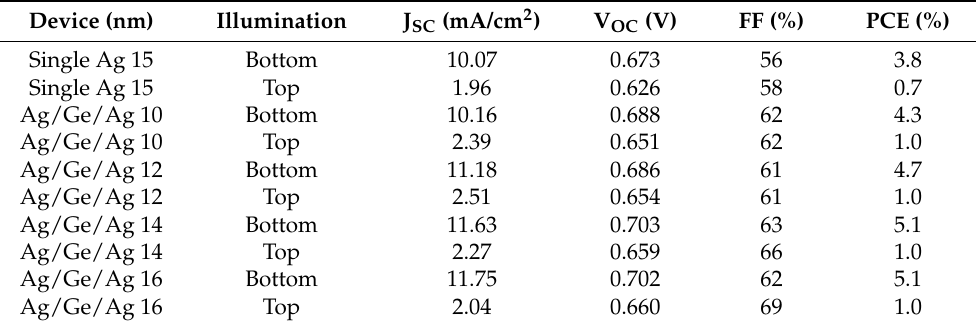
Table 1. Characteristic data of semitransparent inverted PSCs with different thicknesses of the Ag capping layer, as illuminated from the ITO (bottom) and the Ag/Ge/Ag (top) sides. Device